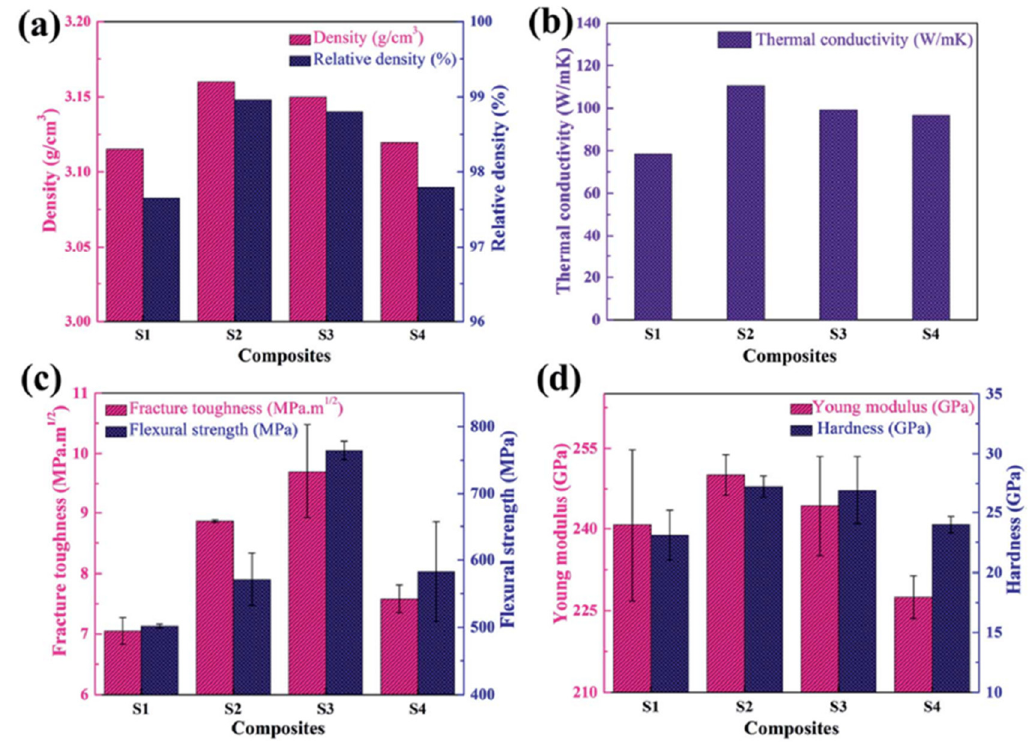
Figure 12. The properties of CNS-reinforced Si 3 N 4 /SiC CMCs: ( a ) bulk and relative densities, ( b ) thermal conductivity, ( c ) fracture toughness and flexural strength, and ( d ) Young’s modulus and hardness. The composites are labelled as S1 (CNS-free composites), S2 (CNF-CMCs), S3 (MWCNTs-CMCs), and S4 (GNP-CMCs). (Reprinted from ref. [127]).